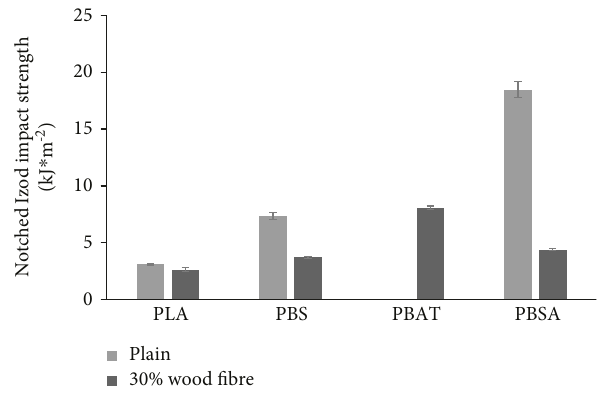
Figure 3: Apparent viscosity of plain PLA and PLA fi lled with 30 wt % MDF fi bre (180 ° C and 1Hz). The same materials containing Joncryl®, a chain extender, are also represented. For reference, PP containing 30 wt % MDF fi bre is